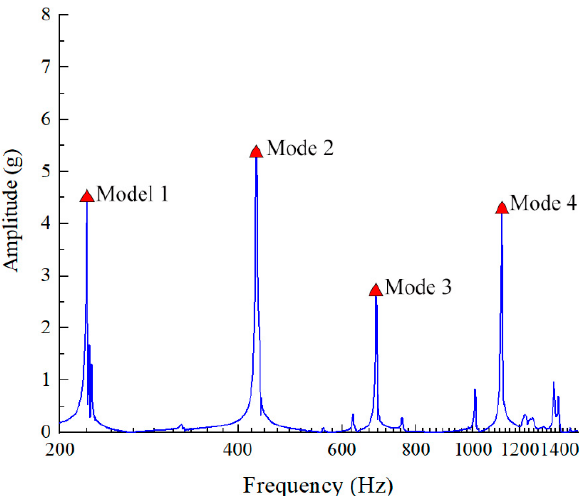
Table 1. Frequency sweep test conditions.